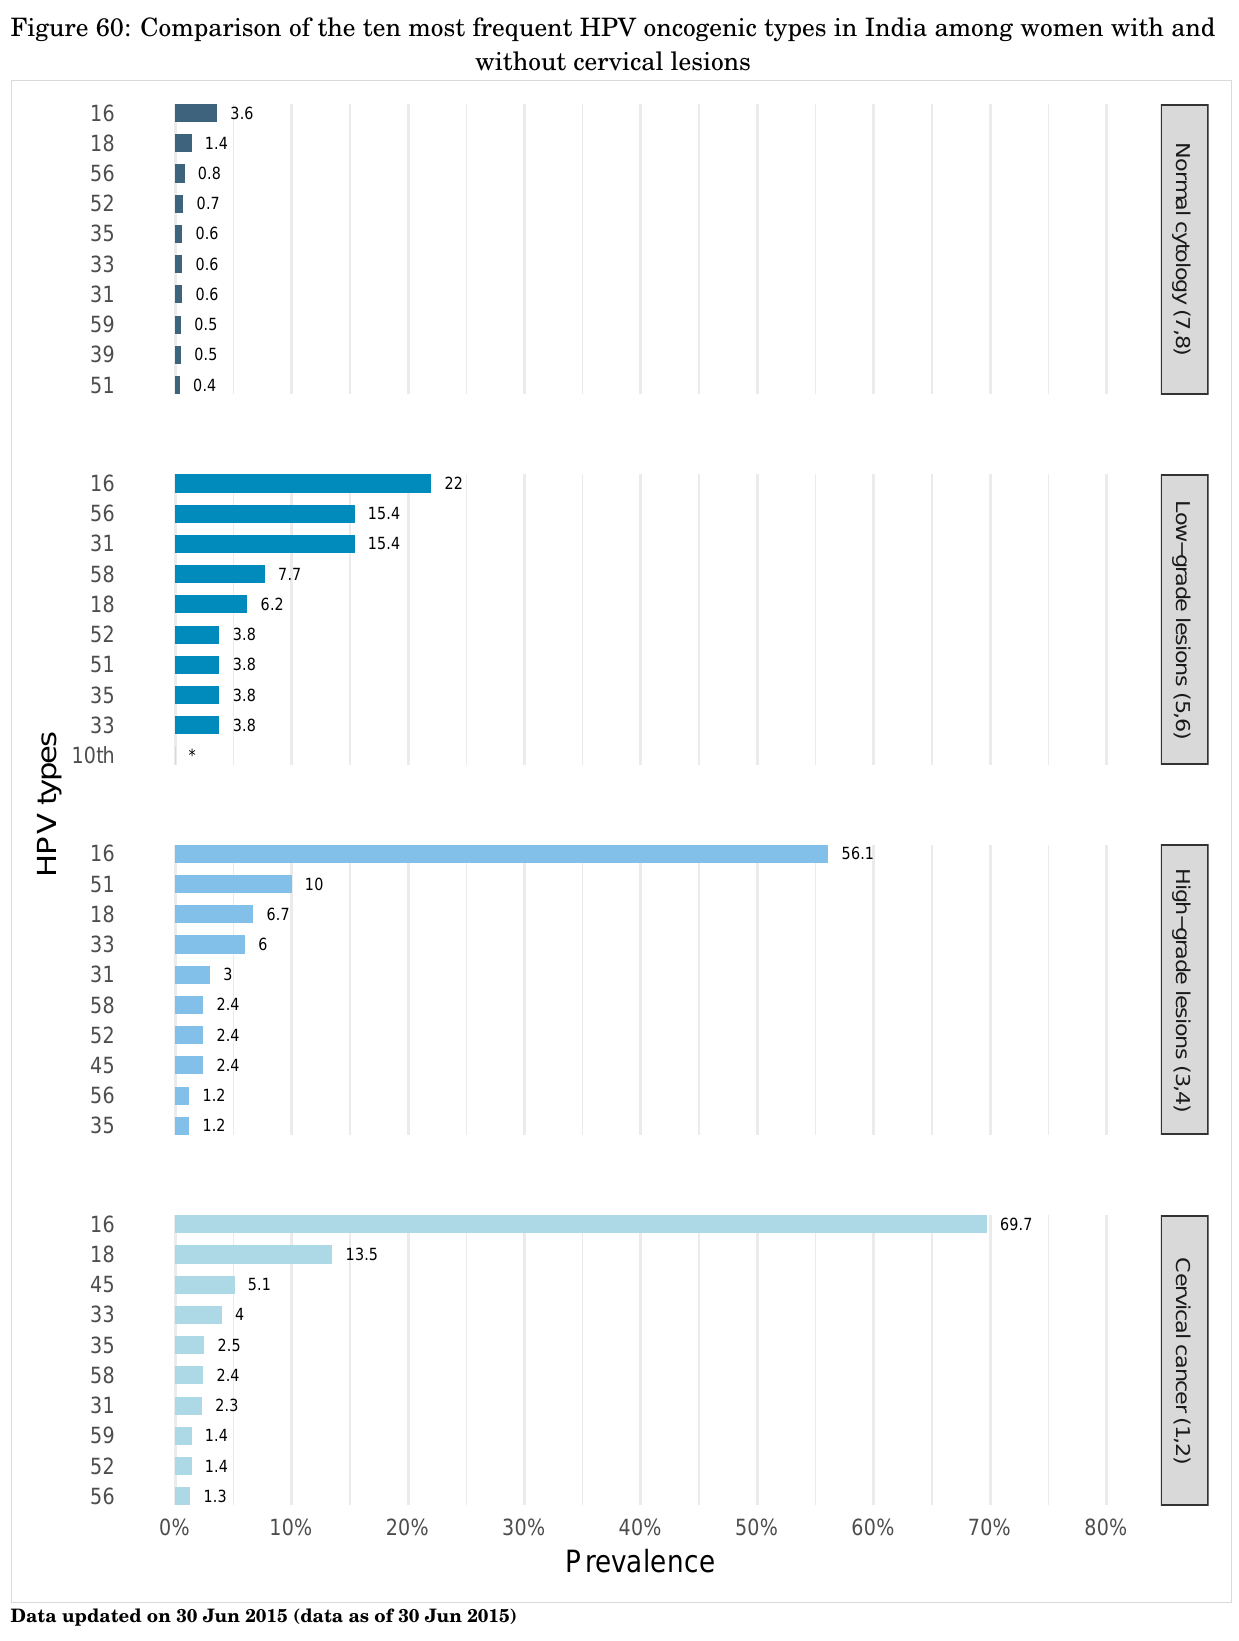
Figure 60: Comparison of the ten most frequent HPV oncogenic types in India among women with and without cervical